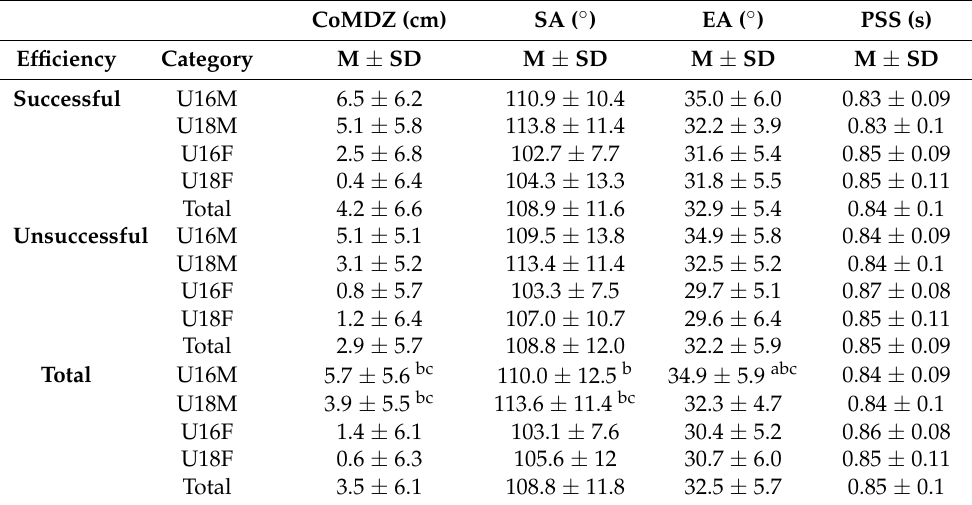
Table 1. Descriptive statistics of selected kinematic variables for 2-pt shooting according to efficiency and category. CoMDZ (cm) SA ( ◦ ) EA ( ◦ ) PSS